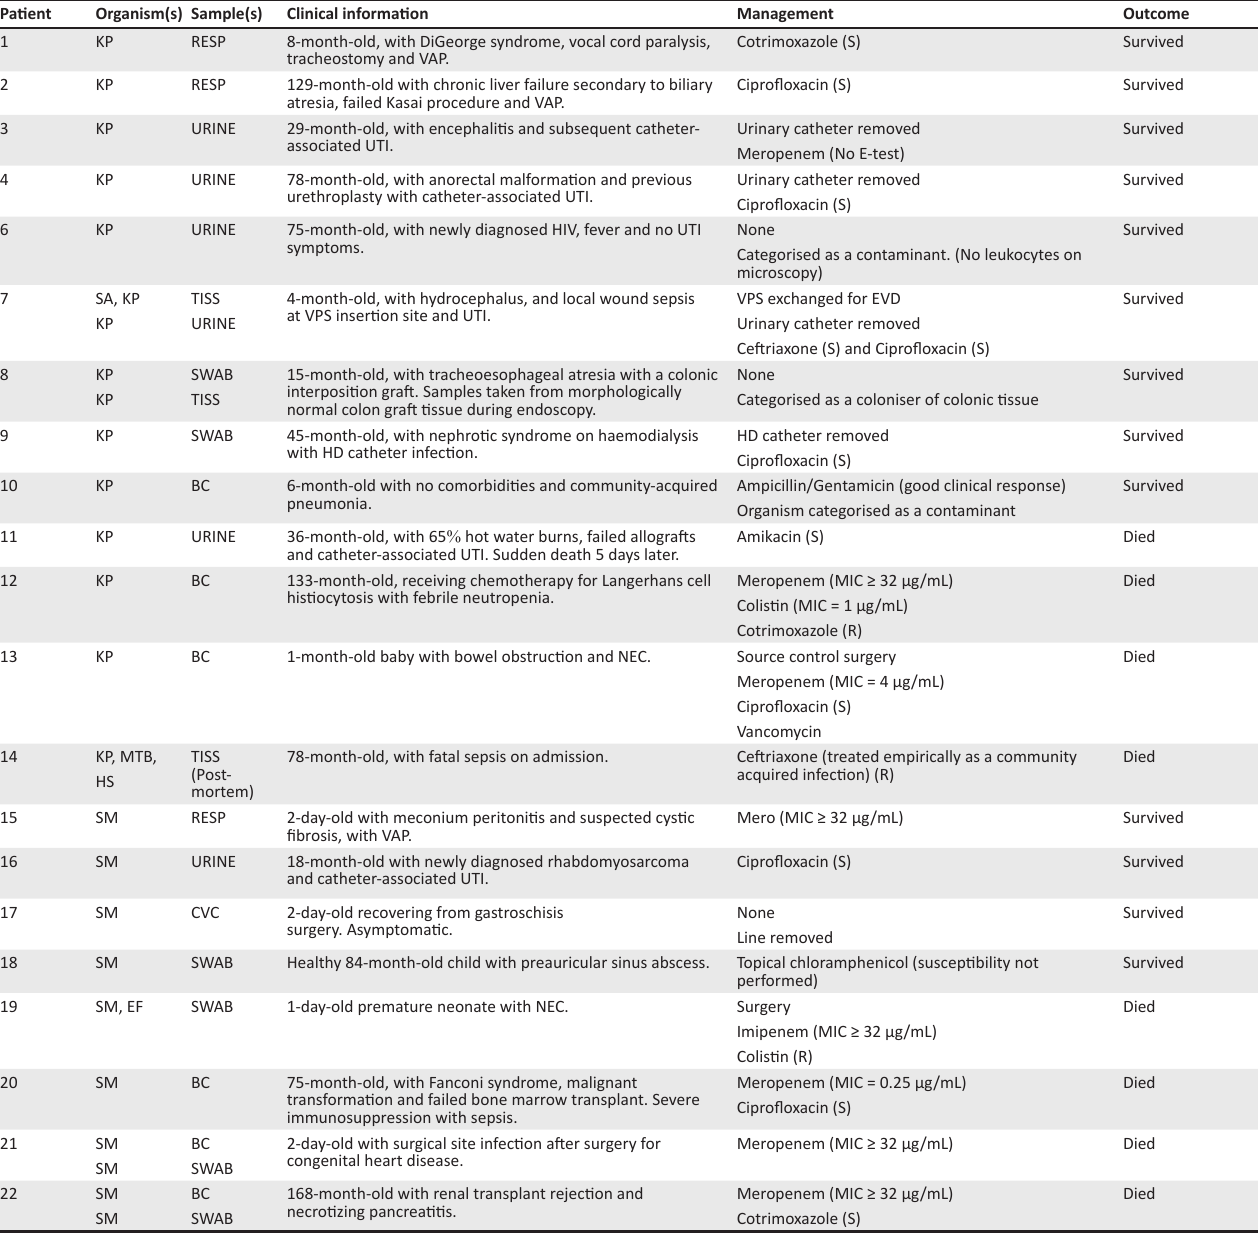
TABLE 1: Clinical characteristics, management and outcome of children with NDM-producing Enterobacterales. Patient Organism(s) Sample(s) Clinical